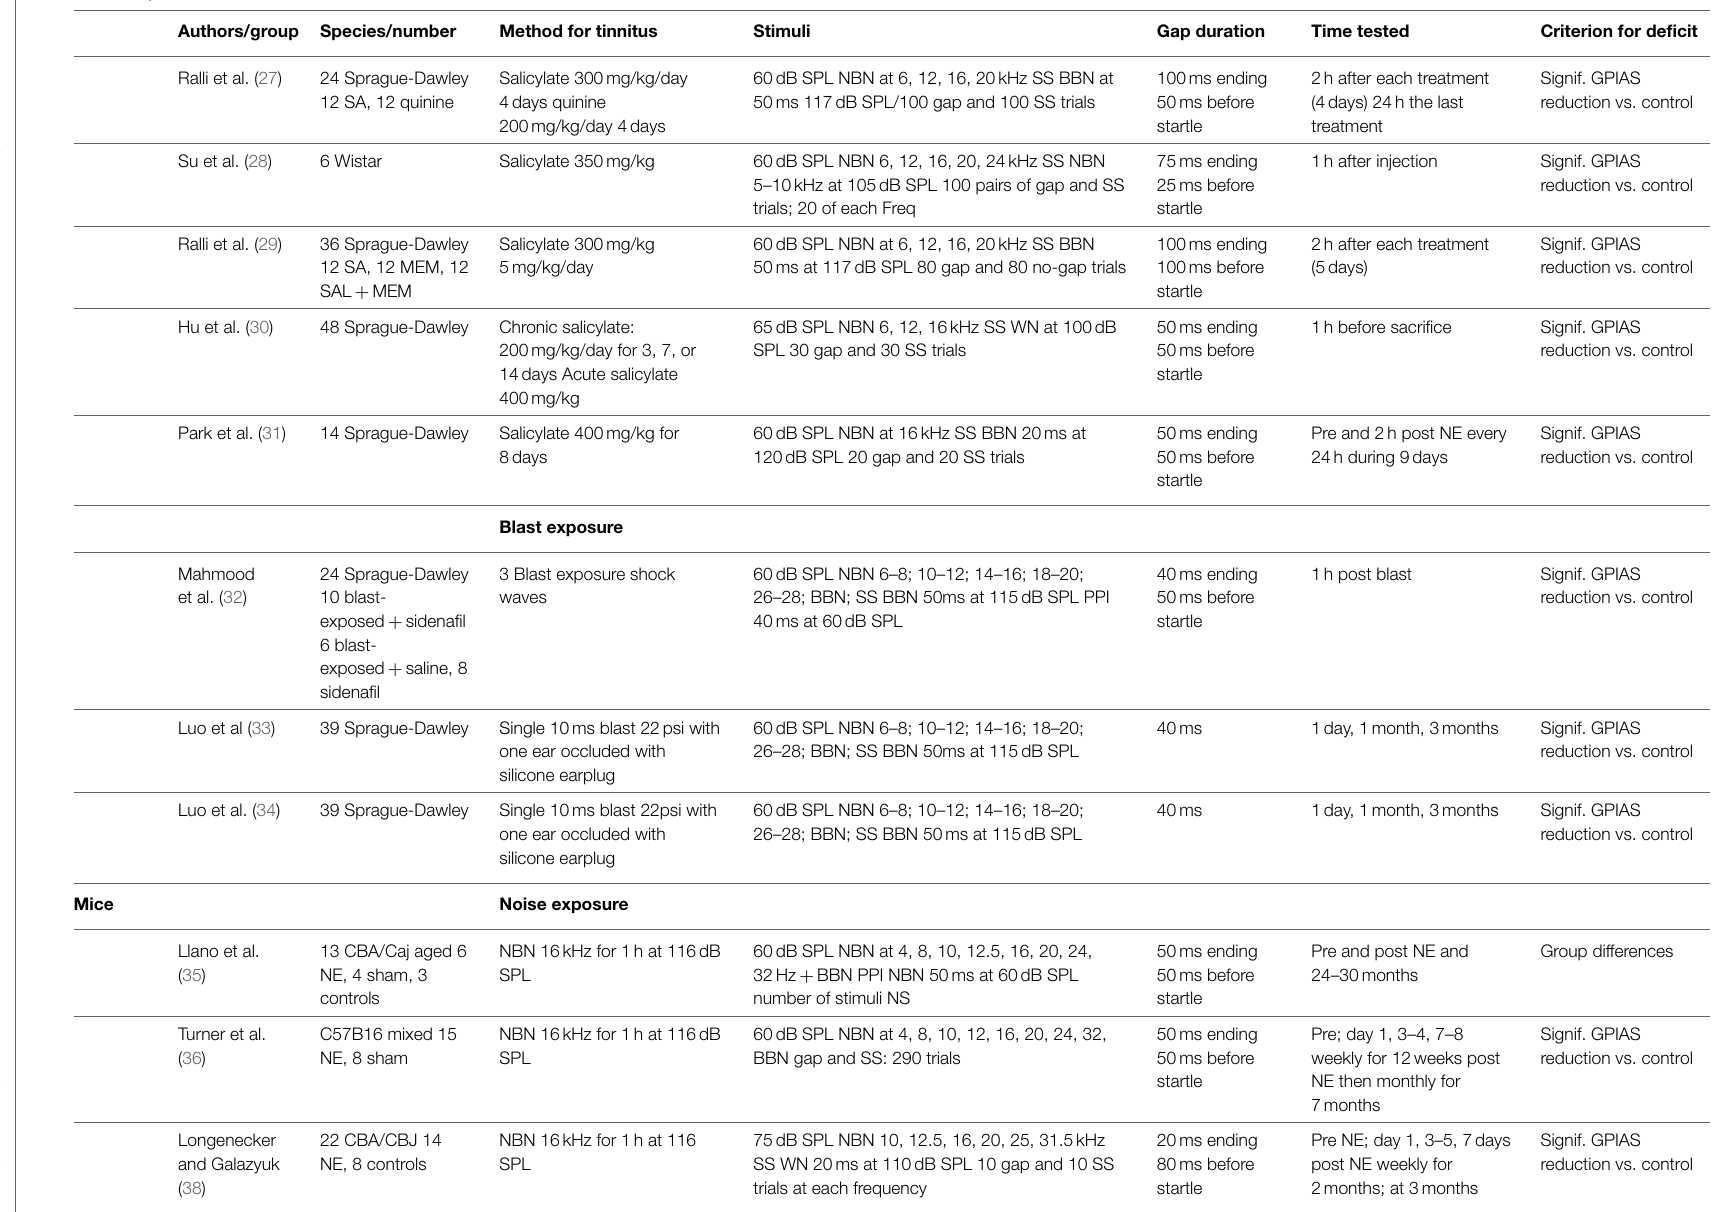
Signif. GPIAS reduction vs.